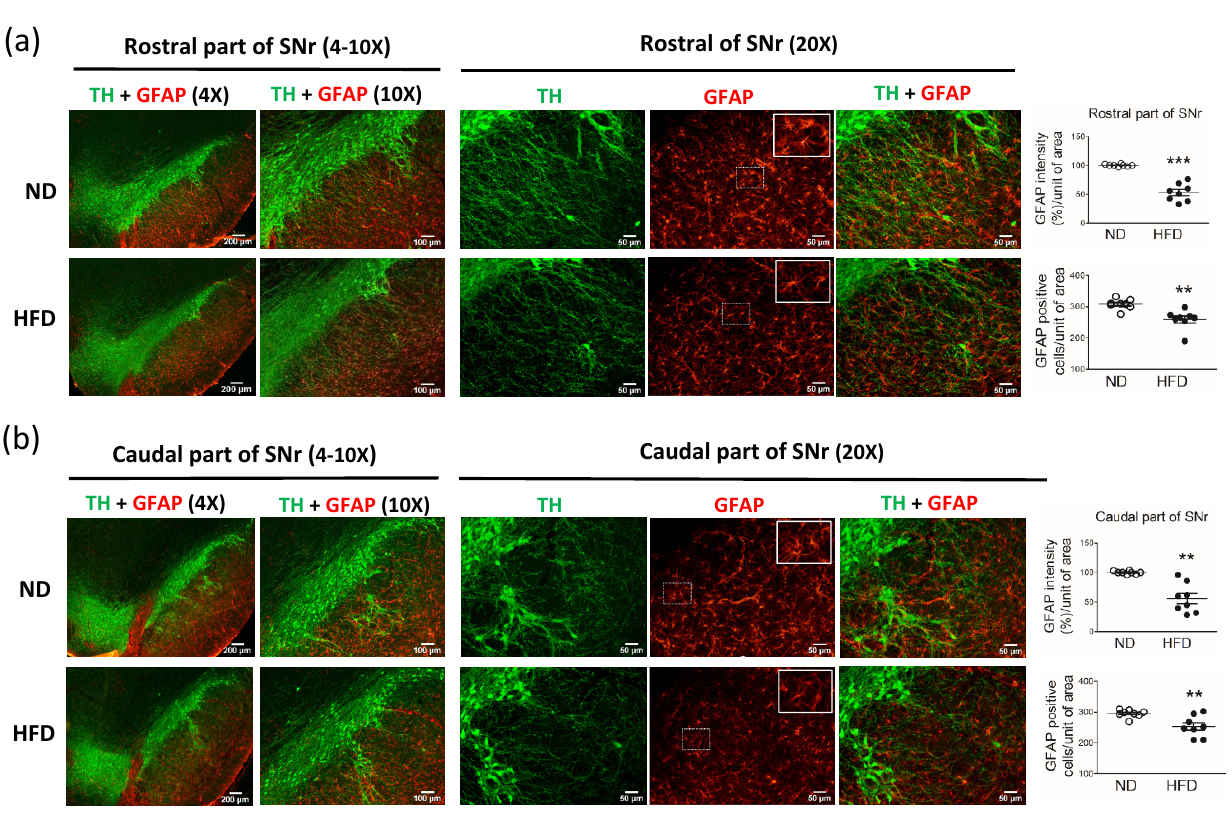
Figure 5. Immunostaining of astrocytes (GFAP-positive cells) in the substantia nigra pars reticularis (SNr) after middle-aged rats were fed a normal diet (ND, control, n = 8) or 45% high-fat diet (HFD, n = 8) for 30 weeks. Data were captured with 4X (scale bar = 200 μ m), 10X (scale bar = 100 μ m), and 20X (scale bar = 50 μ m) objectives. Immunostaining for GFAP in neurons in the ( a ) rostral part of the SNr and ( b ) caudal part of the SNr. As shown on the right, the GFAP immuno-intensity (%) and GFAP-positive cells per unit of area (20X objective) were quantified by using cellSens Dimension software (Olympus). Data are expressed as the mean ± SEM. ** p < 0.01, *** p < 0.001 between groups ( t -test).